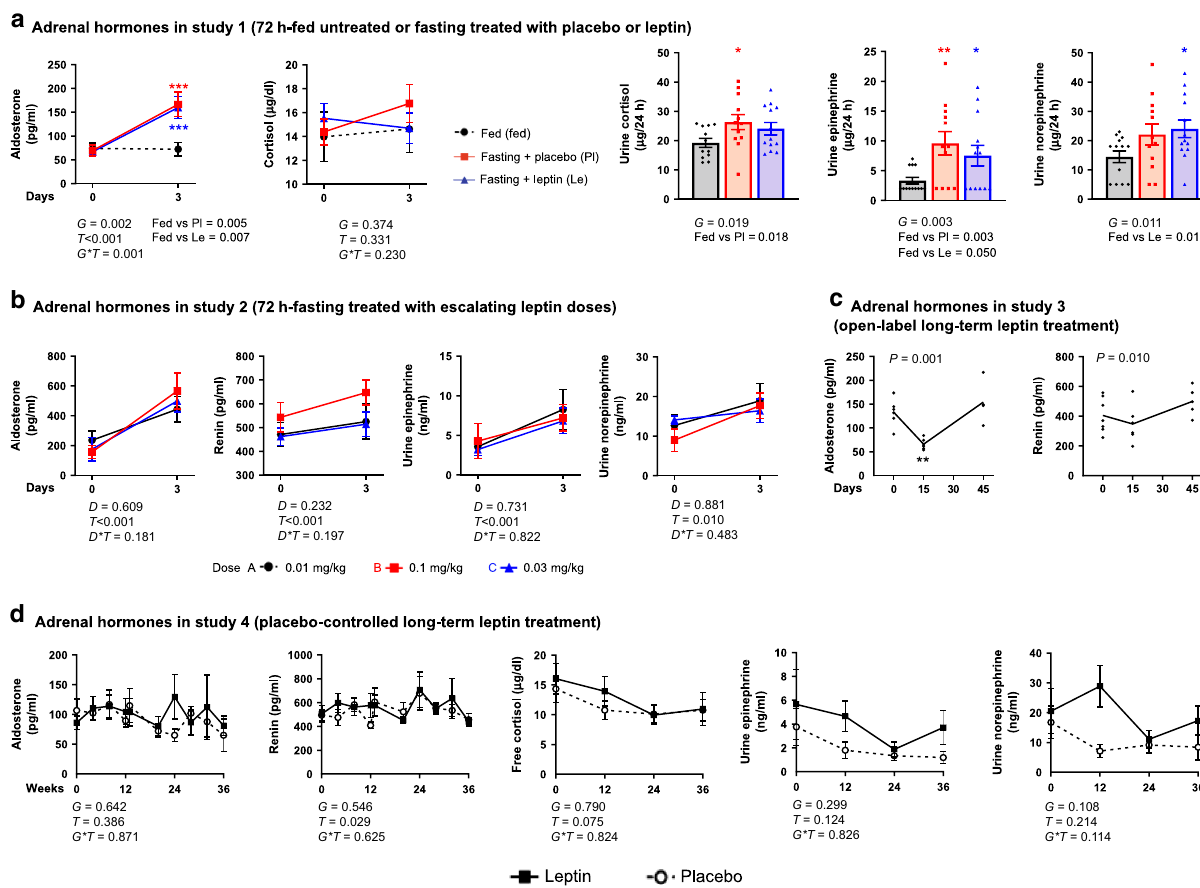
Fig. 5 Leptin effects on adrenal hormones. a Seventy-two hours fed state or fasting + leptin or fasting + placebo (study 1, n = 13). Left: blood aldosterone and cortisol at the start and completion of the study. Right: 24-h urine cortisol, epinephrine, and norepinephrine collected at the last day of the study. P values of G (group: fed or fasting + placebo or fasting + leptin), T (time: days of study), and G * T interaction of mixed models, adjusted for baseline are reported. For urine catecholamines, P values were calculated with repeated measure ANOVA, since only the group factor existed. By G * T < 0.05 (blood aldosterone and cortisol) and by G < 0.05 (urine catecholamines), post hoc Bonferroni test was performed between the estimated means of the three groups and between the three groups at each timepoint. Three asterisks indicate P < 0.001 for fed vs fasting + placebo (red) and for fed vs fasting + leptin (blue) at the particular timepoint. b Seventy-two hours of fasting treated with escalating leptin doses (study 2, n = 15). P values of D (dose: 0.01 or 0.1 or 0.3 mg/kg/d), T (time: days of fasting), and D * T interaction of mixed models adjusted for baseline are reported. No post hoc Bonnferroni test was performed since D * T > 0.05. c Open-label long-term leptin treatment in mildly hypoleptinemic women (study 3, n = 7). P value ( P ) of time effect (i.e., days of study) of mixed models adjusted for baseline is reported. By P < 0.05 post hoc Bonferroni ’ s test for each timepoint compared to baseline was additionally performed and two asterisks indicate P < 0.01 for the speci fi c timepoint vs 0 (baseline). d Placebo-controlled long-term leptin treatment in mildly hypoleptinemic women (study 4, n = 19 (leptin = 10; placebo = 9)). P values of G (group: placebo or leptin), T (time: weeks of study), and G * T interaction of mixed models adjusted for baseline are reported. No post hoc Bonnferroni test was performed since G * T > 0.05. For Bonferroni post hoc tests, only signi fi cant results are reported. All P values are two-sided. Data are demonstrated as means ± SEMs. Exact P values : a aldosterone T = 0.001 × 10 − 3 ; day 3 post hoc test for fed vs Pl = 0.004 × 10 − 2 ; fed vs Le = 0.006 × 10 − 2 . b Aldosterone T = 0.001 × 10 − 15 ; renin T = 0.005 × 10 − 17 ; urine epinephrine T